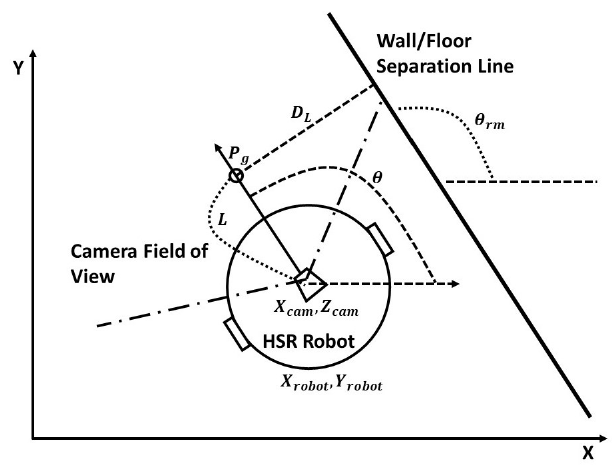
Figure 6. HSR robot navigates along a wall/floor segmentation